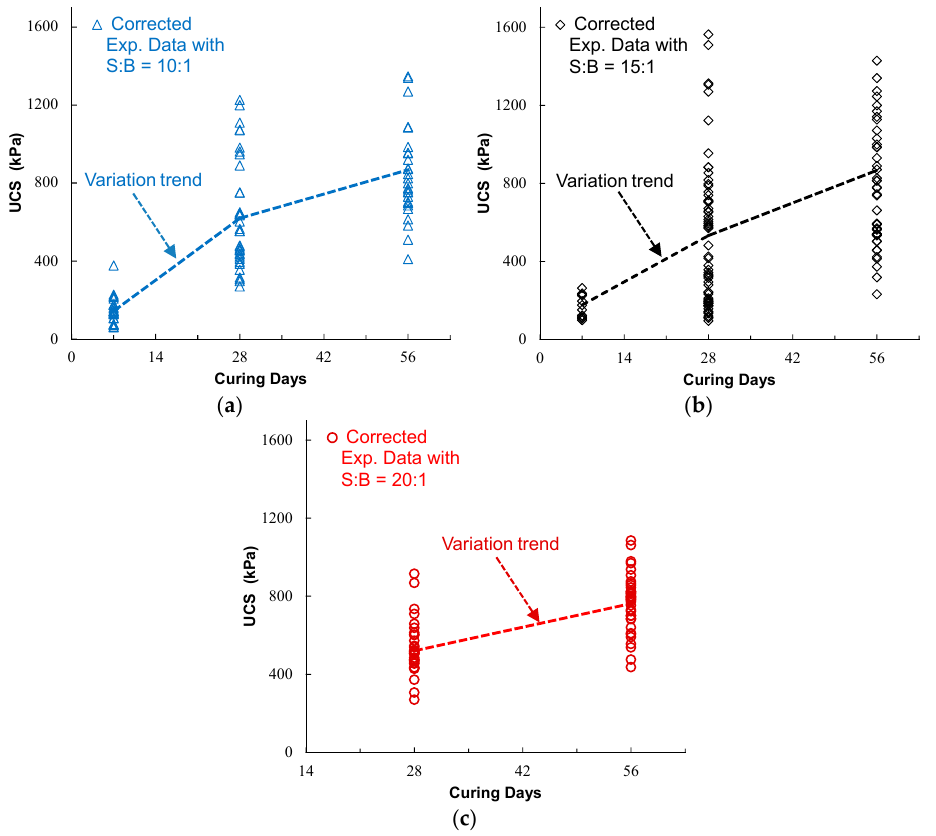
Figure 5. Variation of the UCS results obtained on cylindrical samples of cemented hydraulic backfill with a constant pulp density of 72% as a function of curing days with sand to binder ratios (S:B) of ( a ) 10:1; ( b ) 15:1; and ( c ) 20:1, respectively (with correction of the shape effect).